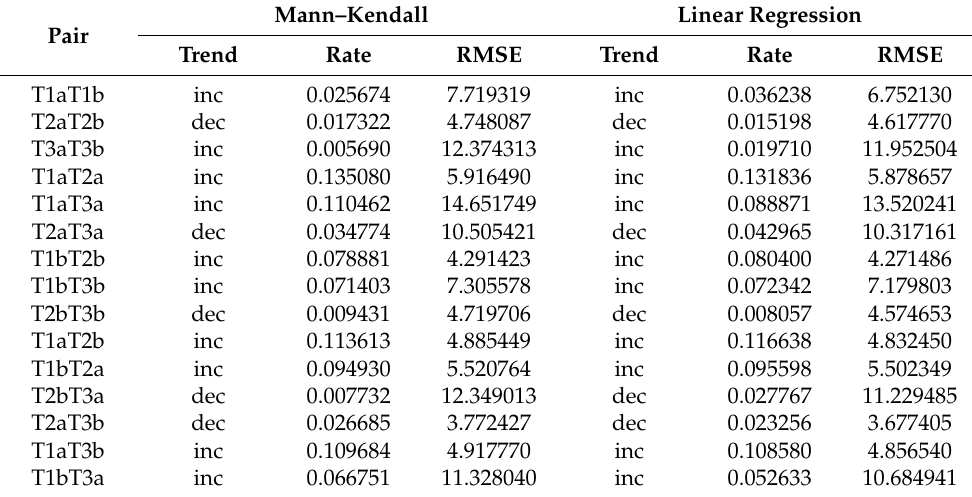
Table 2. Results of trend detection methods with calculated trend rates and RMSE values for each of the sensor